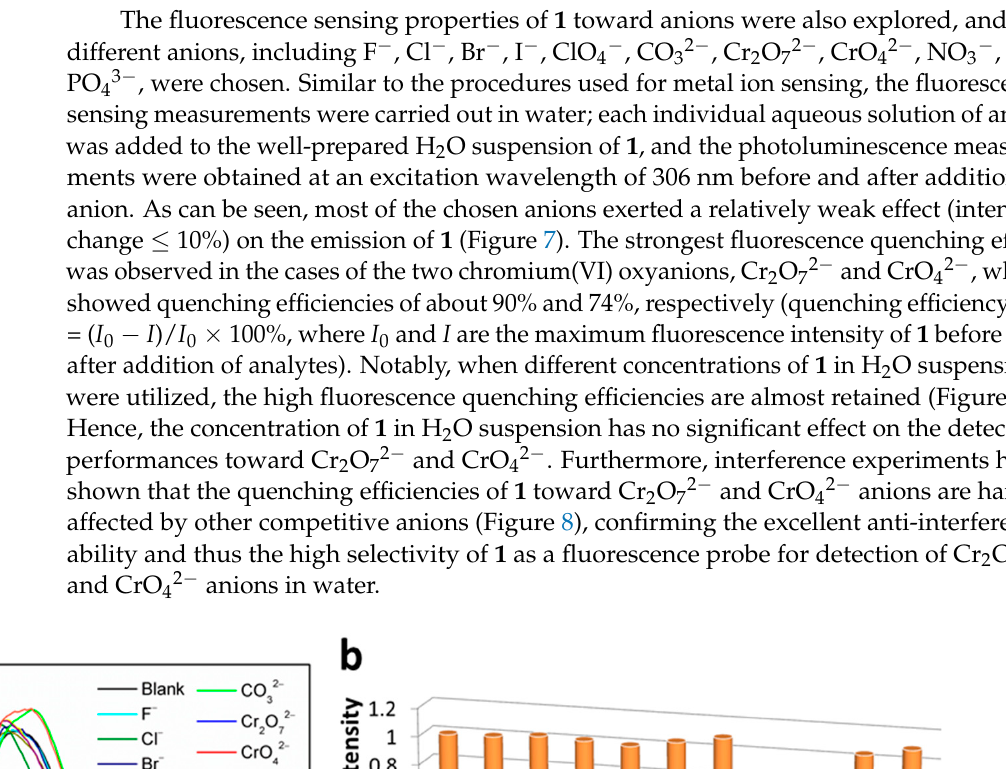
Figure 8. Fluorescence relative ratio responses of 1 in H 2 O suspensions containing various anions before and after addition of Cr 2 O 72 − /CrO 42 − ions with equal concentrations at 1.0 mM.